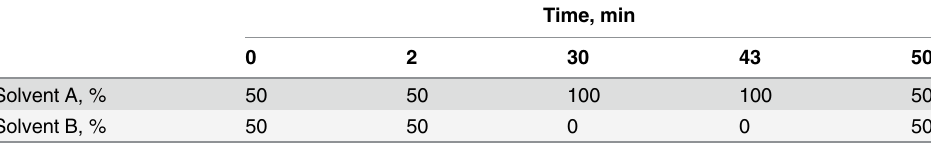
Table 1. HPLC elution scheme and solvents used in the separation of phytoplankton pigments.